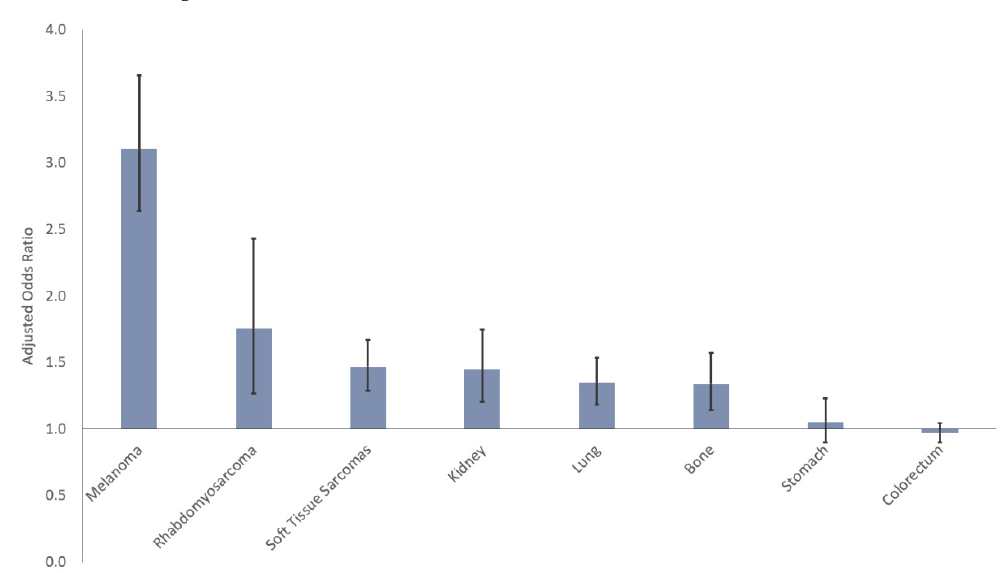
Figure 4. Risk of metastatic disease for male AYAs by cancer site. Reference group: female AYAs.